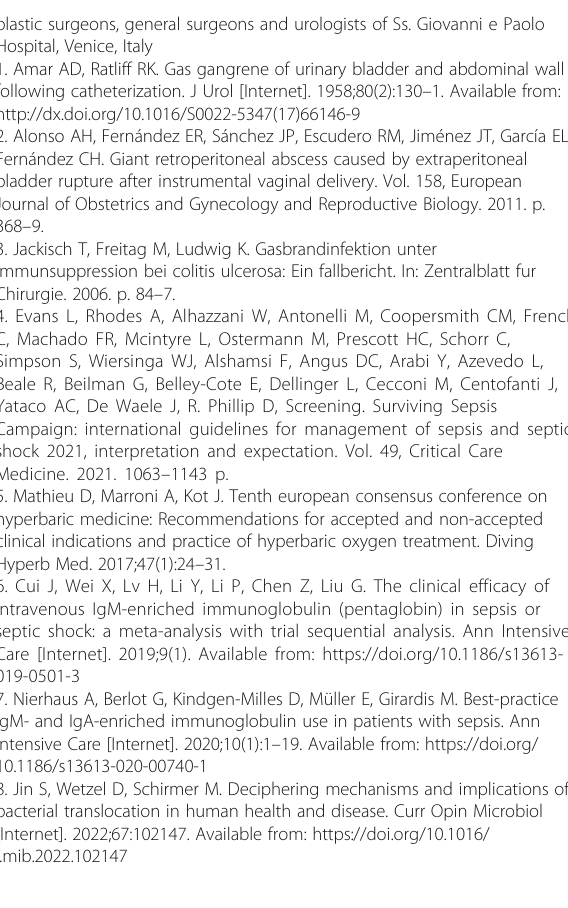
Table 1 (abstract A104). General characteristics of the